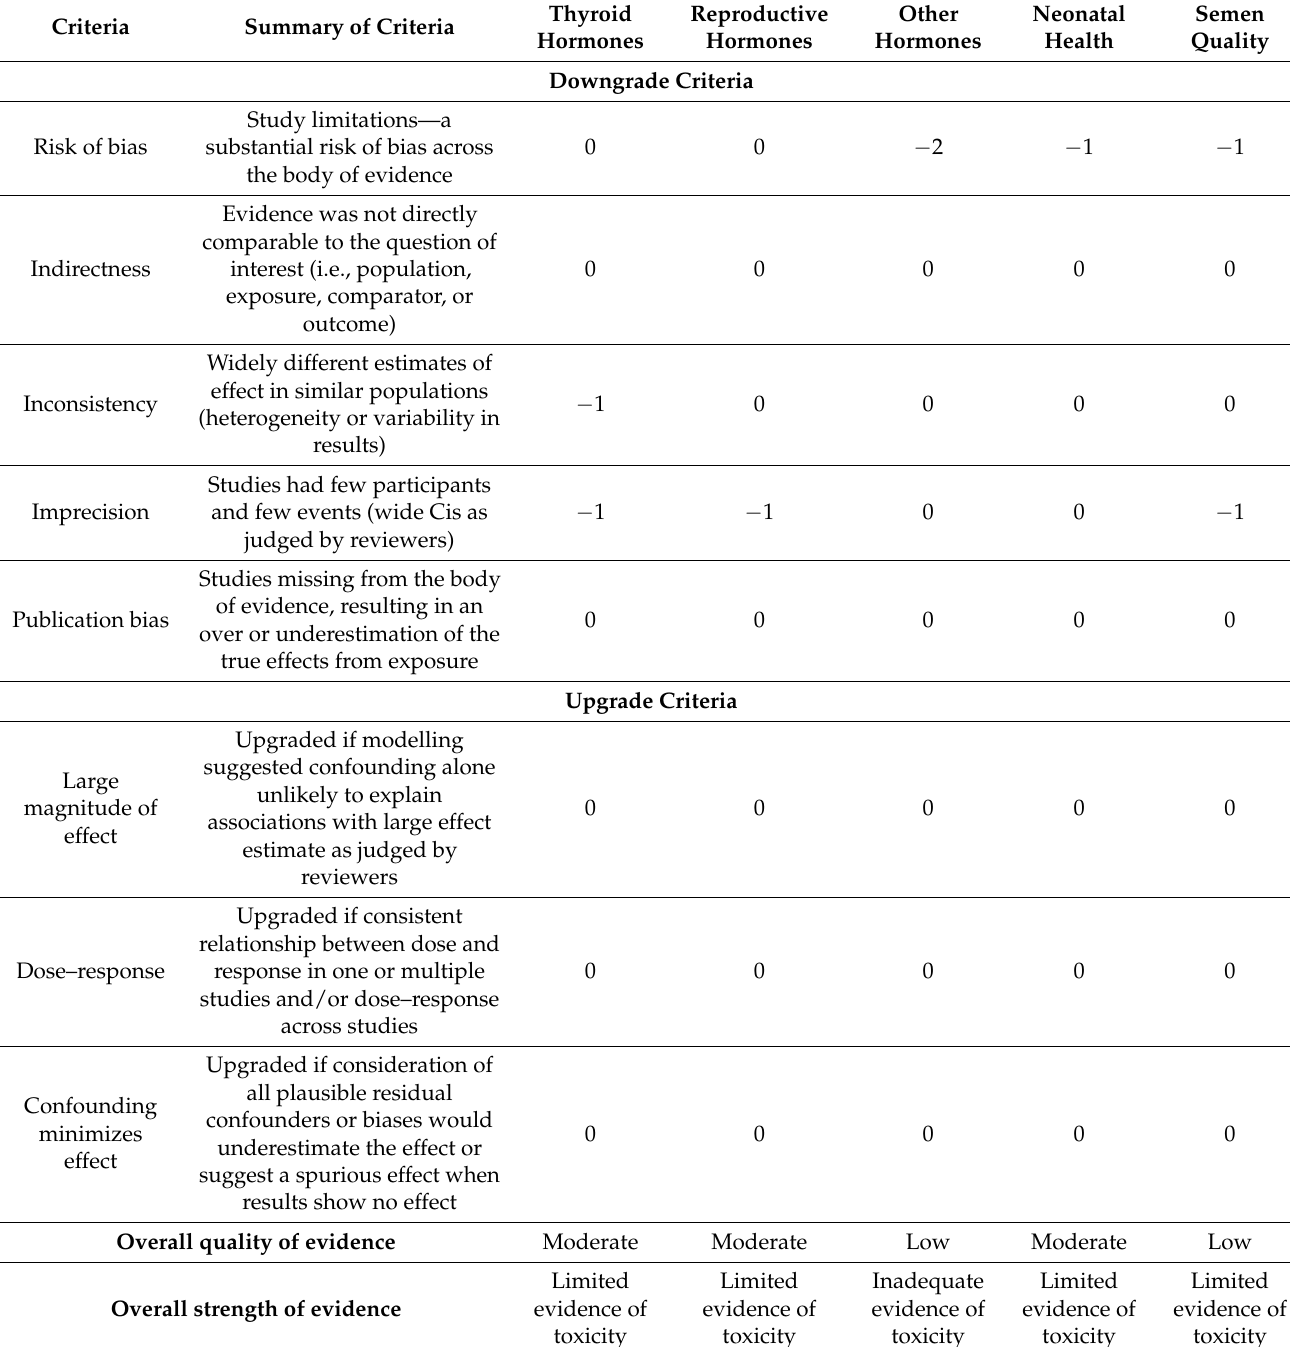
Table 4. Summary of quality and strength assessment ratings across